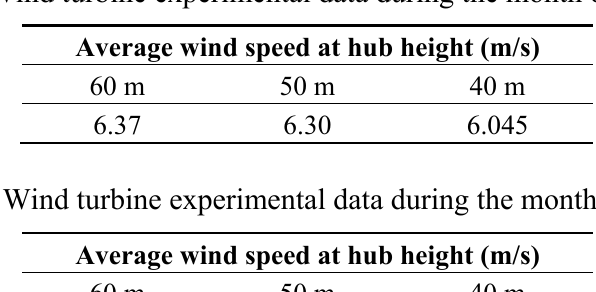
Table 2. Wind turbine experimental data during the month of February.